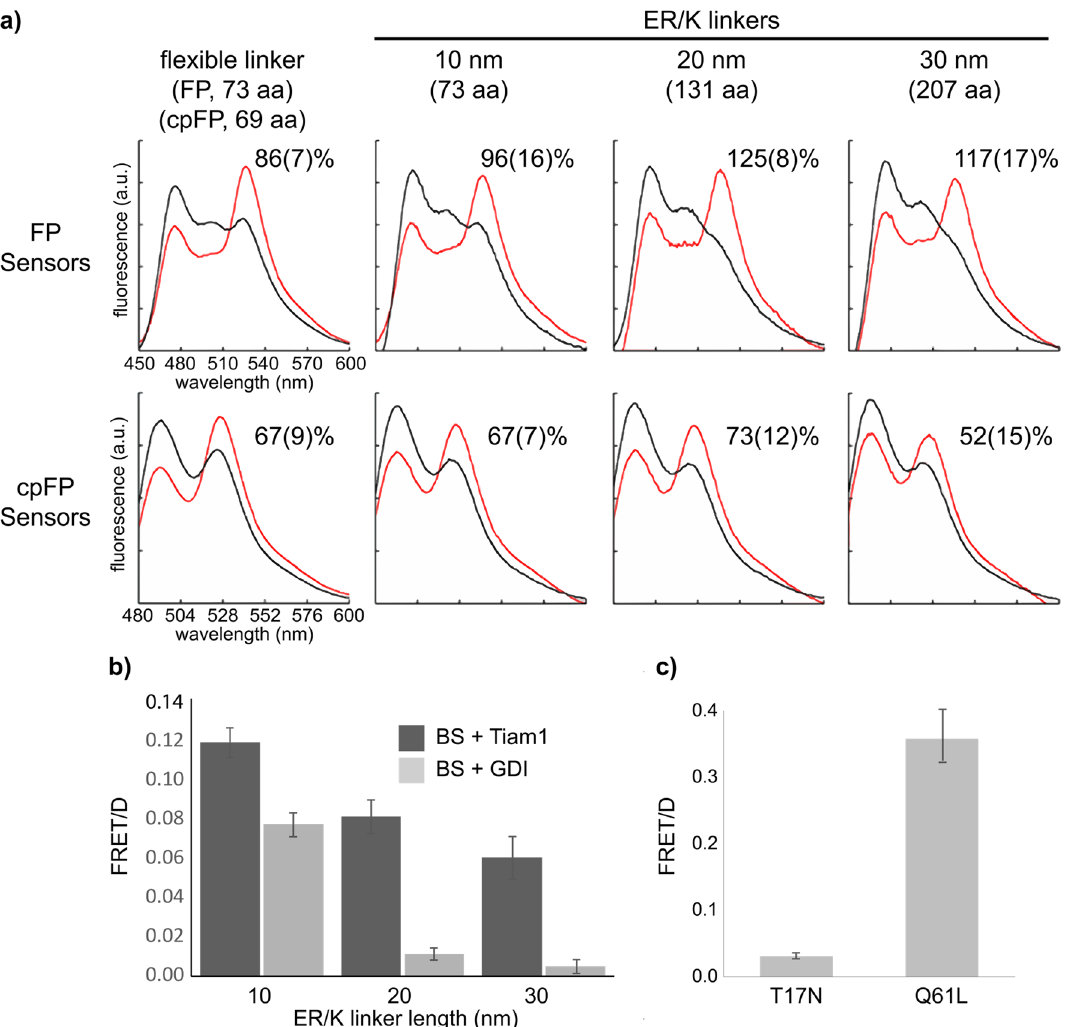
Figure 2. Evaluation of Rac1 biosensors by fluorometry and TGL luminescence. Rac1 biosensors were evaluated by co-expressing each sensor with Tiam1 (On state, red trace in ( a ) or black bar in ( b ) or RhoGDI (Off state, black trace in ( a ) or gray bar in ( b ) in 293 T cells. ( a ) Cells co-expressing FP or cpFP sensors and the regulators were scanned for emission profiles in cell suspension using a cuvette-based fluorometer. ΔR/R i values representing differences in FRET efficiency between the On and Off states are shown for the indicated biosensor. ( b ) Cells co-expressing LRET biosensors and the regulators were grown in a 96-well plate. Following overnight incubation, cells were treated with lysis buffer containing TMP-TTHA-cs124 (25 nM). The time- gated emission (gate delay, 0.2 ms) at 520 nm (Tb-to-GFP LRET) and 615 nm (Tb only) were measured using a time-resolved fluorescence plate reader. Substantially larger 520 nm/615 nm (FRET/D) ratios were observed in the positive control wells (Tiam1) relative to those seen in the negative controls (RhoGDI). ( c ) 293 T cells expressing inactive (Rac1 T17N) or active (Rac1 Q61L) mutants of the LRET biosensor with 30 nm ER/K linker were grown in a 96-well plate and underwent the same lysis-buffer treatment and plate-reader measurement as in ( b ). Fluorescence spectra in ( a ) are representative of cells transiently expressing biosensors with transfection efficiency > 70%. Dynamic range values represented as mean(sem) (n ≥ 3 transfections). Error bars in ( b ), ( c ), sem (n ≥ 3 transfections/plates; 16 wells/plate for each